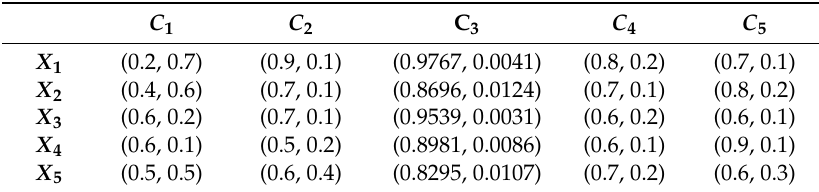
Table 7. Intuitionistic fuzzy decision matrix D 2